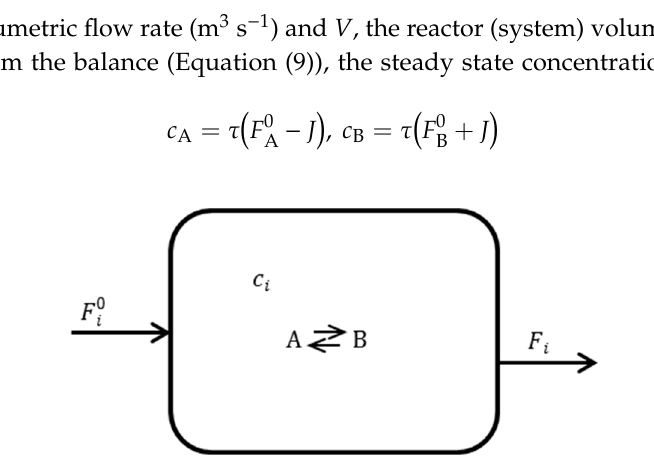
Figure 1. Scheme of the continuous stirred tank reactor (CSTR).